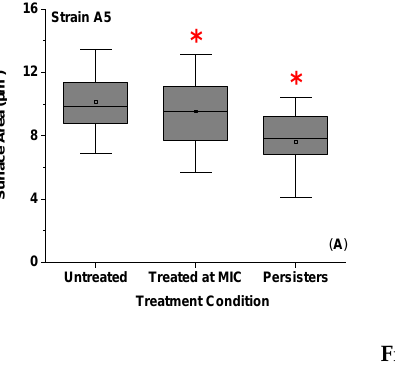
Figure 3. Representative SEM images of: ( A , D ) MDR E. coli untreated cells of Strains A5 and A9, respectively; ( B , E ) cells of Strains A5 and A9 exposed to ampicillin at MIC for 3 h, respectively; and ( C , F ) persister cells of Strains A5 and A9 exposed to ampicillin at 20× MIC, respectively. Red arrows on images C and F for both Strains show intact cells with expected surface morphologies, while blue arrows on images C and F indicate cells with ampicillin-induced damage, n = 3 independent cultures. Note the elongation of A9 cells when treated at MIC (image E ).